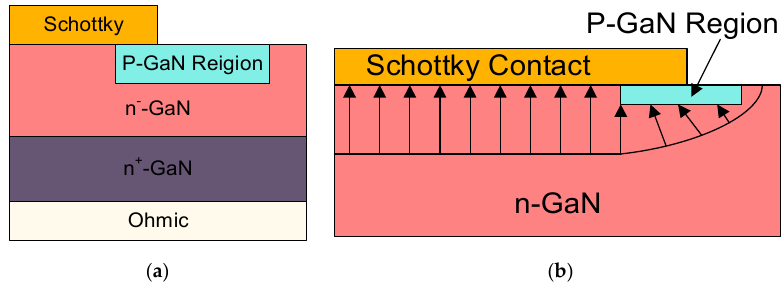
Figure 5. ( a ) Cross-section of GaN SBDs with p-guard ring edge termination structure and ( b ) E-field distribution under reverse bias.